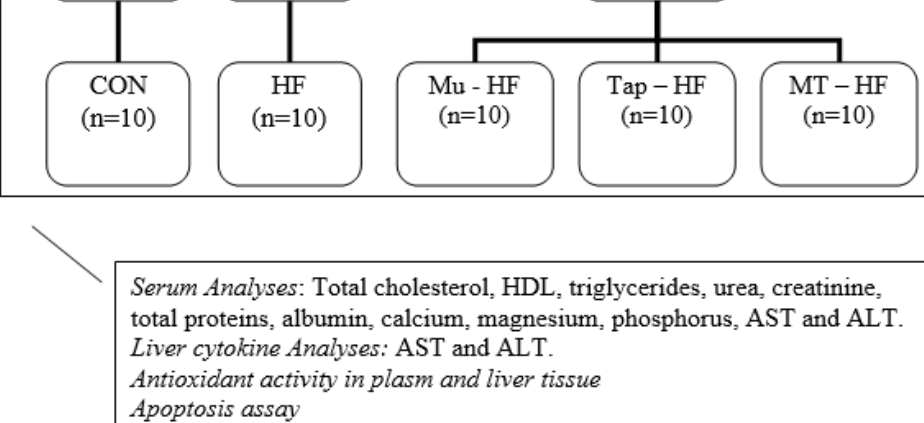
Figure 1. This empirical model: CON: control group. HF: high-fat group. Experimental Groups: Mu-HF: group that received murici fruit-based beverages and high-fat diet; Tap-HF: group that received